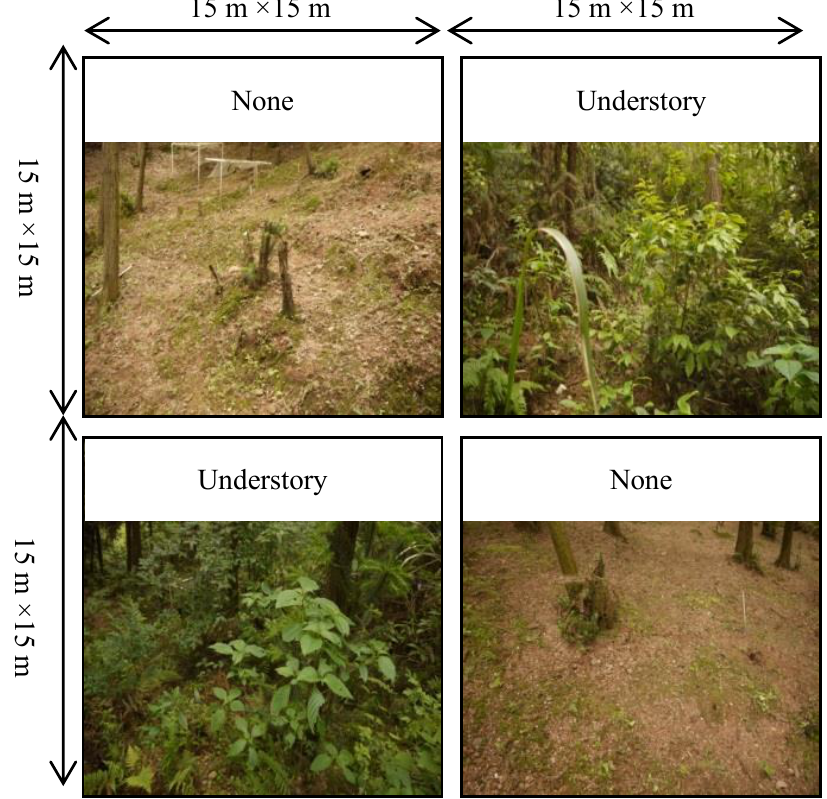
Figure 1. Paired-plot design treatments with understory vegetation and litter removal (None), and understory vegetation intact and litter removal (Understory). The same abbreviations are used